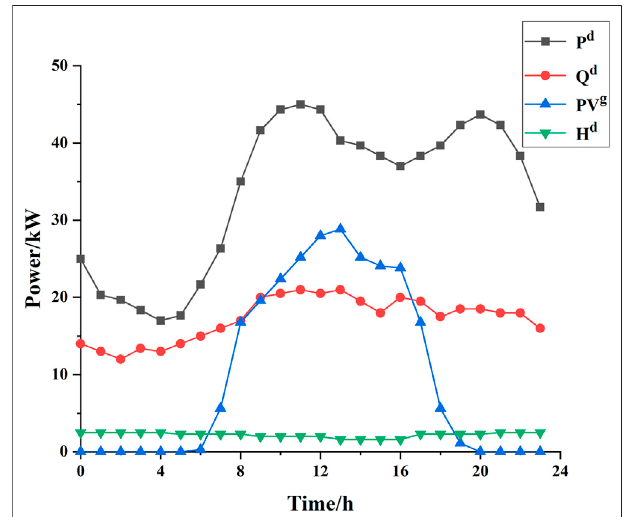
FIGURE 5 | Time-of-use power price.